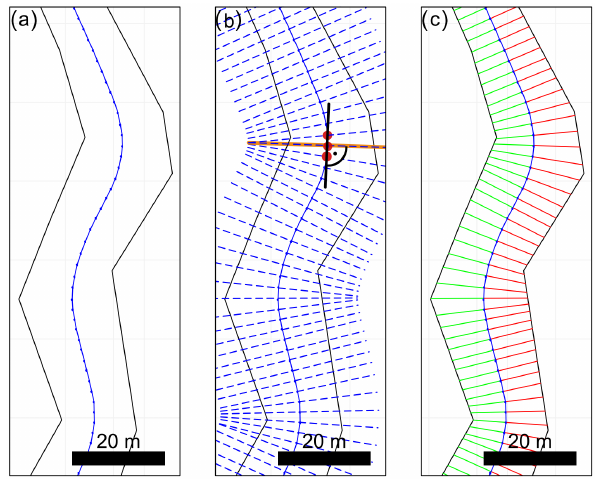
Figure 4. (a) The smoothed centerline; (b) transects are calculated by taking a group of centerline points, creating a line through the outer points and calculating the perpendicular to that line, (c) and calculating the intersections of the transects with the channel